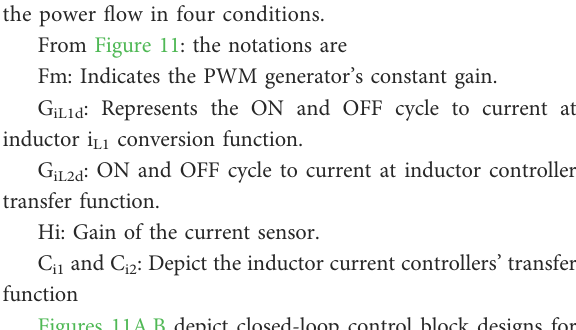
From Figure 11: the notations are Fm: Indicates the PWM generator ’ s constant gain. G iL1d : Represents the ON and OFF cycle to current at inductor i L1 conversion function.